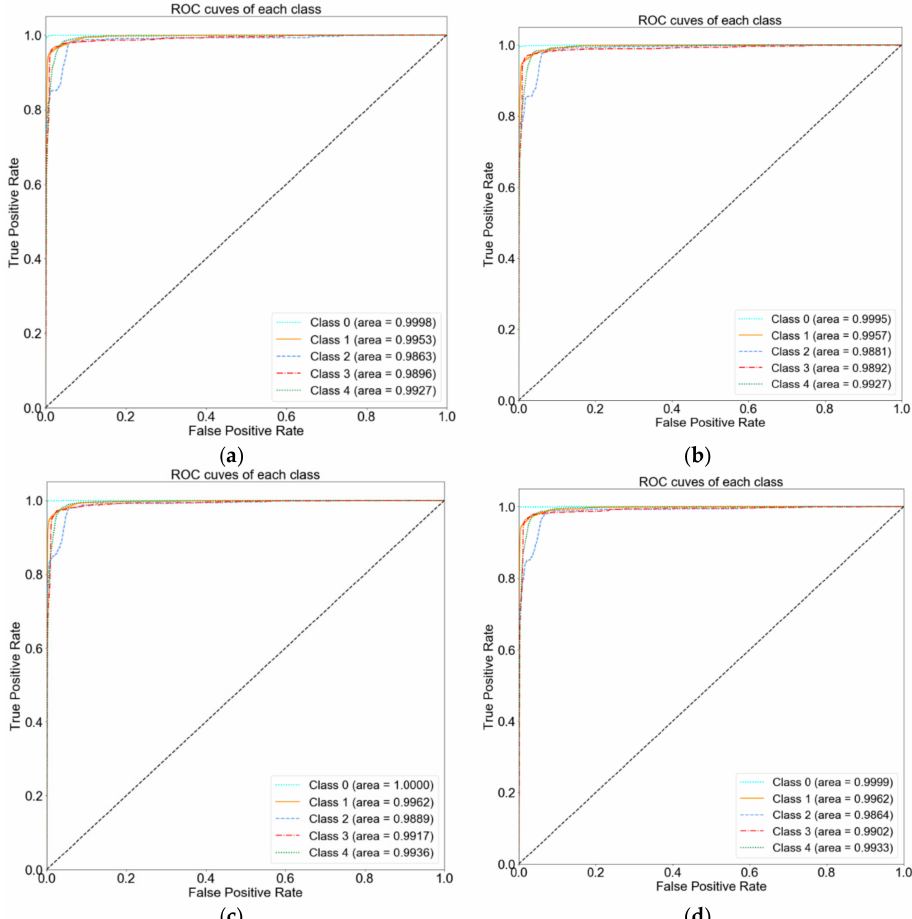
Figure 8. ROC of the ISCX-IDS 2012 dataset: ( a ) proposed process flow, ( b ) standard process flow, ( c ) SFS-DT-based feature selection, and ( d ) SBS-DT-based feature selection.